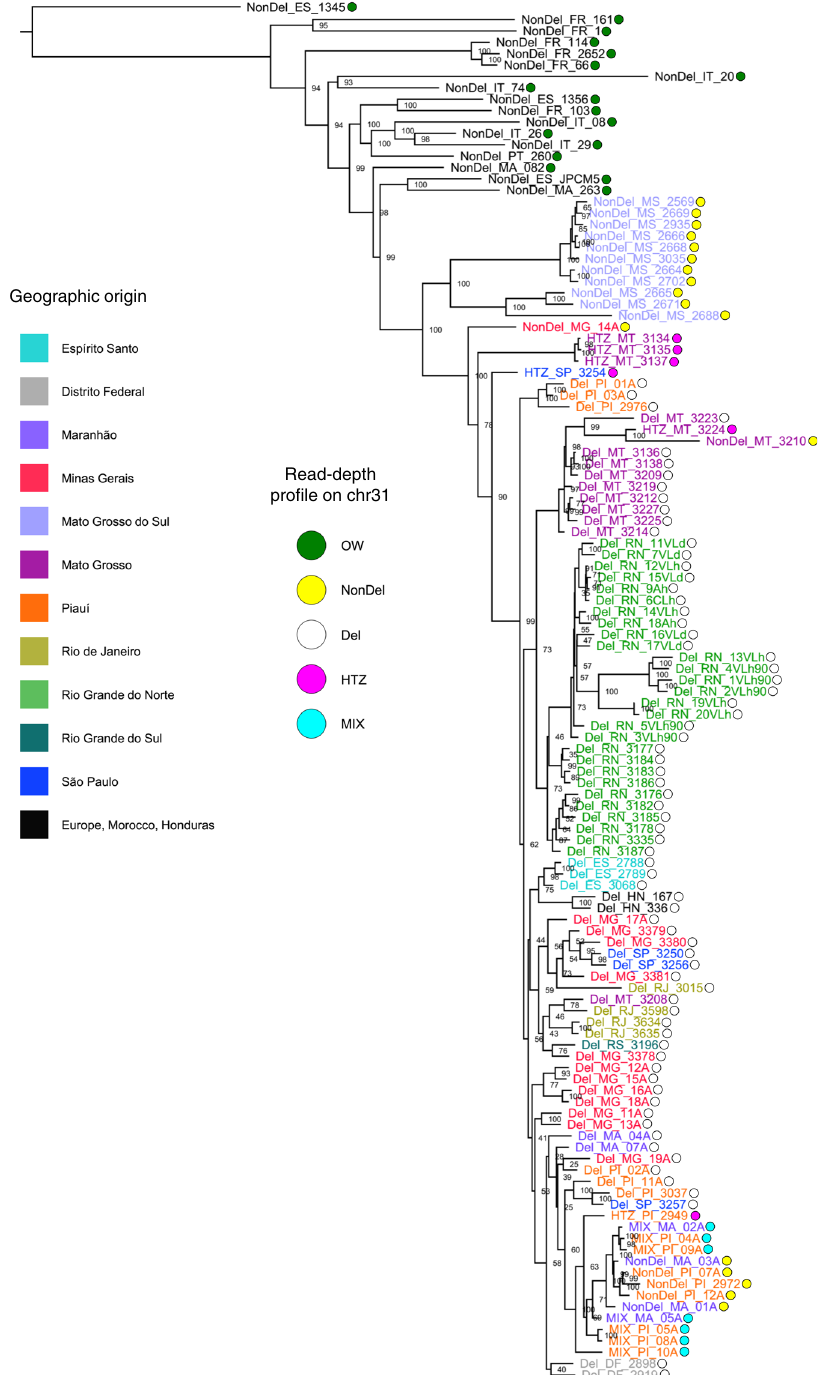
Fig. 4 Phylogenetic relationships among New and Old World L. infantum isolates. The maximum-likelihood tree was built using a general time-reversible substitution model with branch lengths corrected for ascertainment bias (i.e., the use of only nonvariant sites in sequence alignment). Pairwise genetic distances are haplotype-based, de fi ned as the proportion of non-shared alleles across all SNP sites for which genotypes are called for all individuals (i.e., no missing data in alignment). Outlier isolates NonDel_MS_MAM, NonDel_FR_47, NonDel_PT_151, NonDel_PA_317, and NonDel_PA_85 are excluded. L. donovani strain MHOM/NP/03/BPK282/0 was temporarily included as an outgroup, to identify an L. infantum sample to subsequently root the tree. NonDel_ES_1345 became the outgroup. Circle fi ll color indicates New vs. Old World origin and read-depth pro fi le on chr31. Font color speci fi es states sampled in Brazil. Isolates from other countries are labeled in